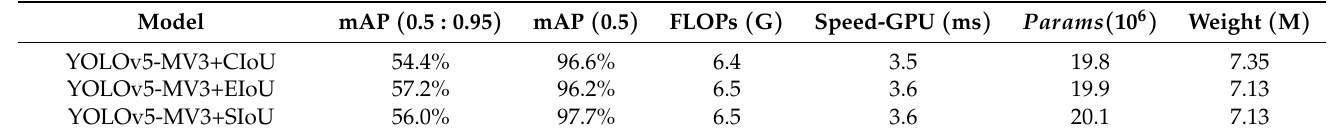
Table 5. Training results of different loss functions of YOLOv5-MV3.